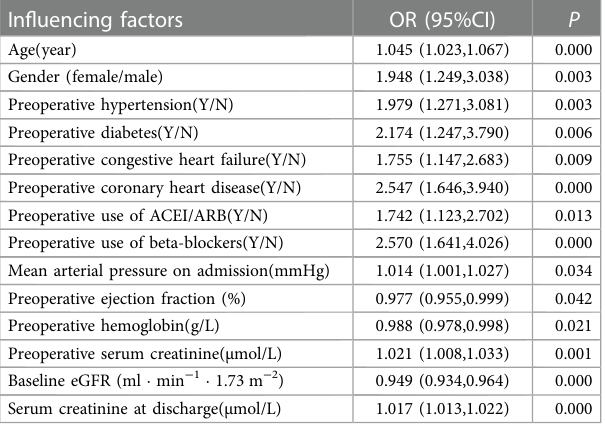
TABLE 2 In fl uencing factors of progression to CKD in patients 90 days after CS-AKI (univariate logistic regression analysis). In fl uencing factors